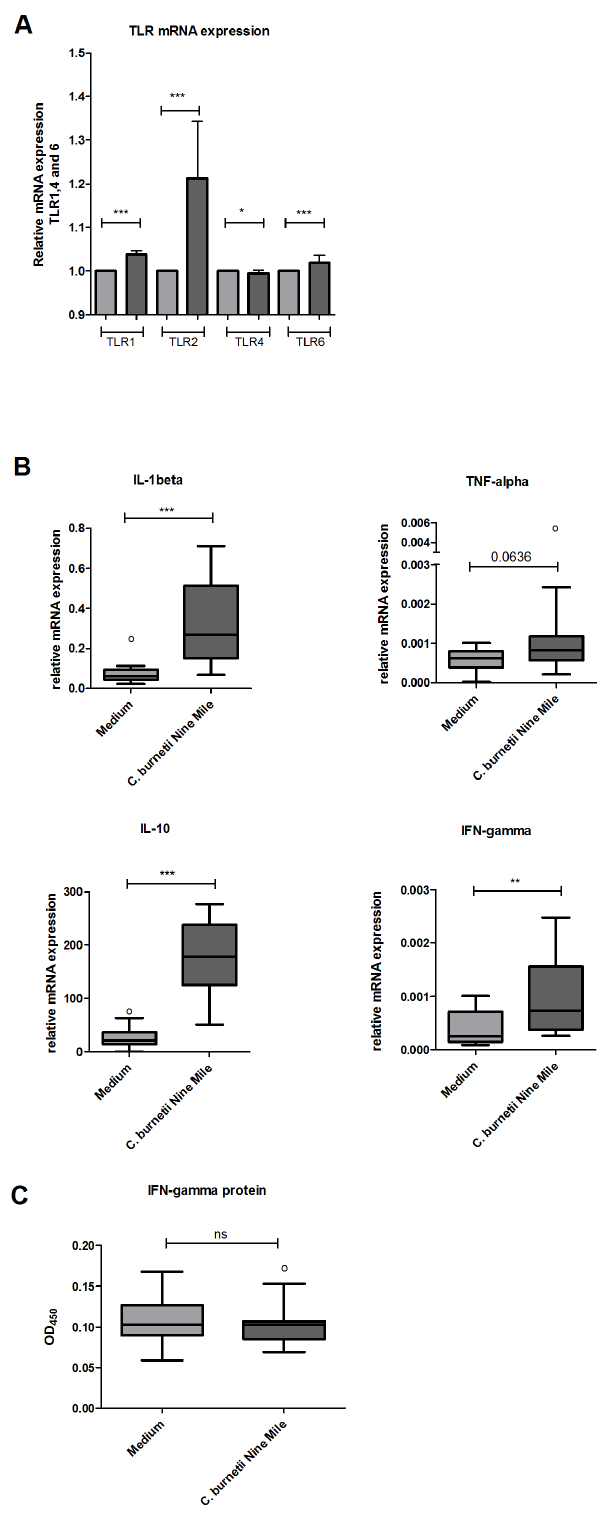
Figure 2. TLR up-regulation and cytokine responses of C. burnetii stimulated PBMCs from naive goats. PBMCs were isolated from EDTA blood sampled from 17 goats prior to inoculation. 2A/B : PBMCs were incubated 4 h (TLRs, IL-1 b , TNF- a ) or 24 h (IL-10, IFN- c ) with either medium (grey bars) or heat killed C. burnetii NM 1 6 10 7 /ml (dark grey bars). mRNA expression of TLR1, 2, 4, 6 and IL-1 b , TNF- a ,